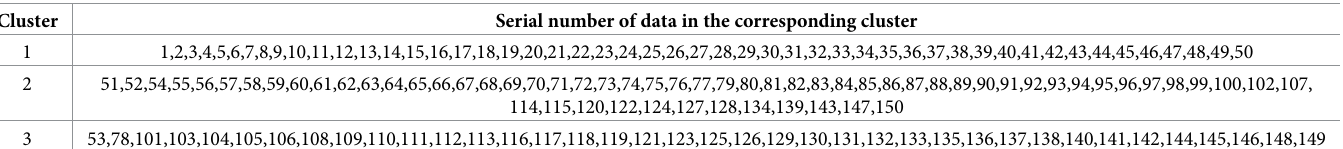
Table 4. The 3 clusters with k-means algorithm. Cluster Serial number of data in the corresponding